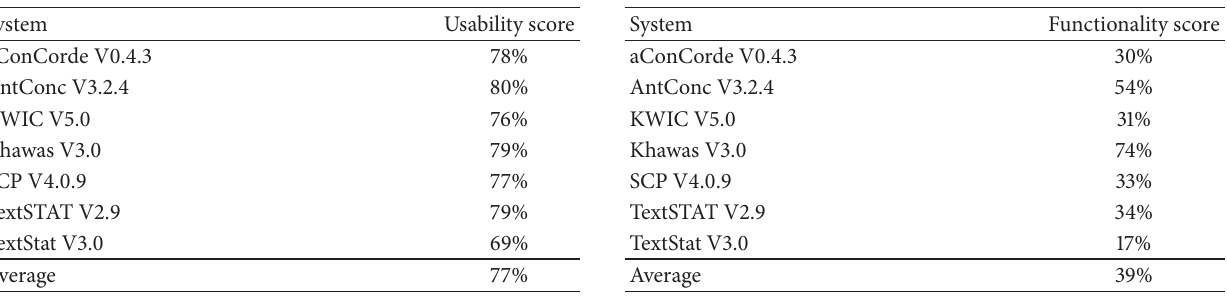
Table 4: Overall functionality evaluation results for the seven